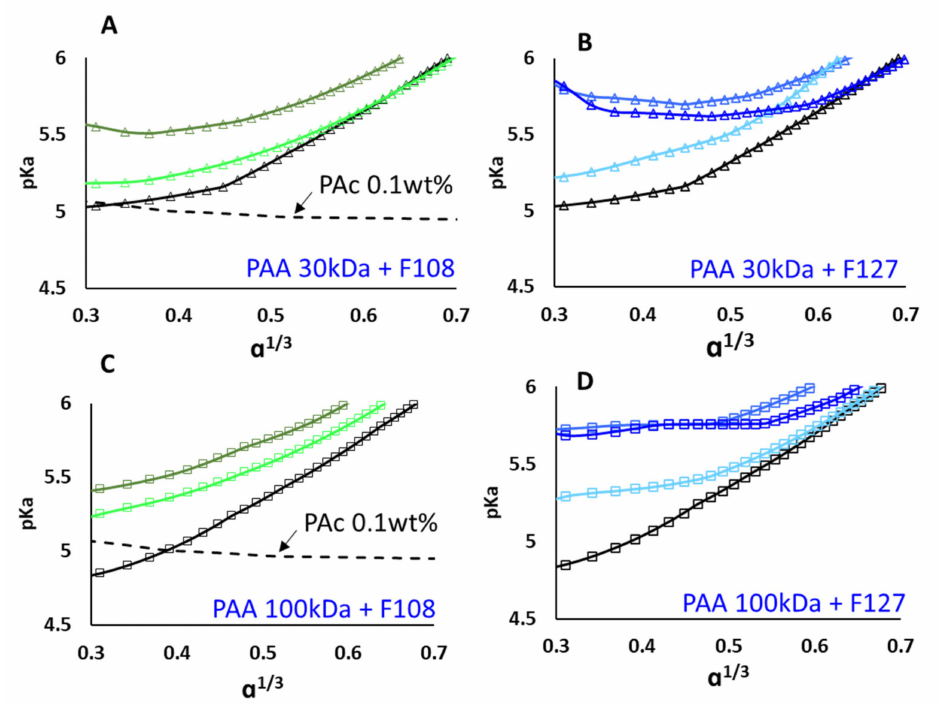
Figure 3. pKa as a function of α 1/3 in PAA (0.1 wt%) solutions containing different concentrations of F108 and F127. PAA 30 kDa ( A , B ), PAA 100 kDa ( C , D ). PAA in water ( black ), PAc in Pluronic solutions (5 wt%) (dashed lines in A , C ). ( A ) PAA 30 kDa in F108 3 wt% (below the CMC, bright green) and in F108 5 wt% (above the CMC, olive green ). ( B ) PAA 30kDa in solutions of F127 3 wt% ( cyan ), 5 wt% (azure) and 7% ( blue ). The same color code applies for PAA 100 kDa presented in ( C , D